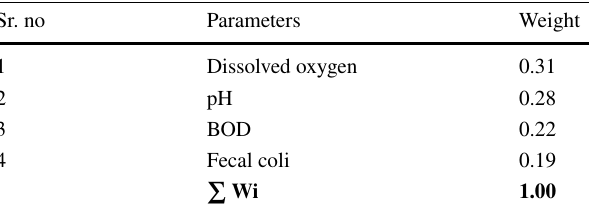
Fig. 1 Location map of study area Table 1 Modified weights for computation of WQI based on DO, FC, pH and BOD Sr. no